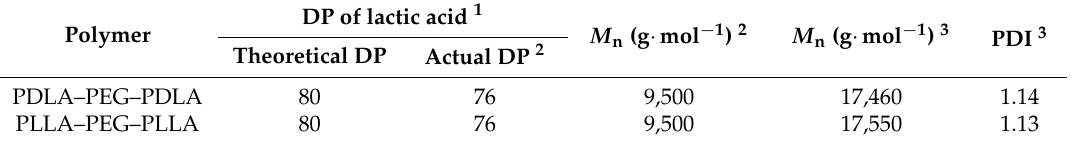
Table 1. Characterization of PLA–PEG–PLA